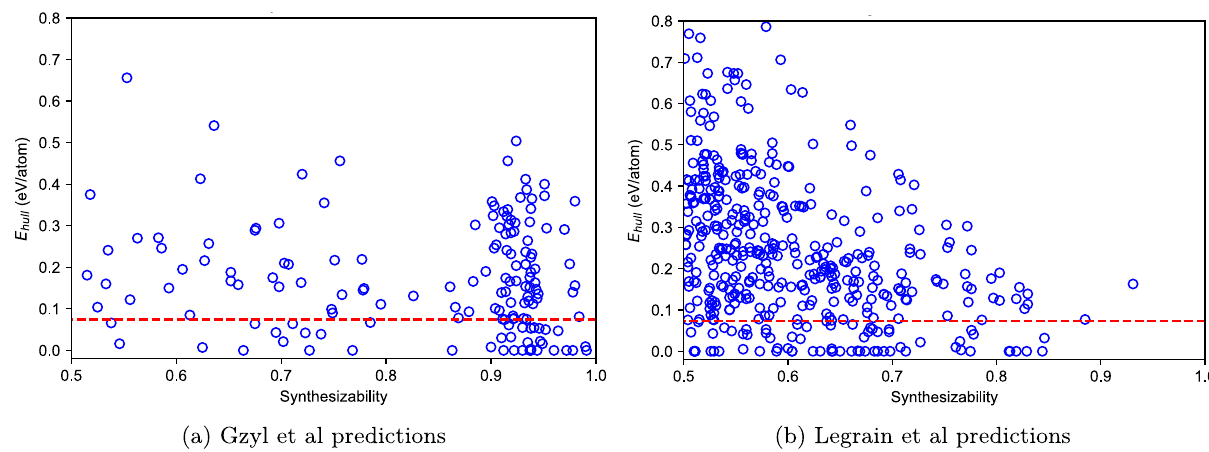
Fig. 2 Synthesizability vs DFT stability for previous half-Heusler models. Comparisons of E hull from the OQMD and synthesizability for synthesizable half-Heuslers as determined by ( a ) Gzyl et al. ’ s 45 and ( b ) Legrain et al. ’ s 46 models. Both models are not informed of DFT stability and predict many unstable half-Heuslers to be synthesizable. The dashed red line depicts the median E hull (73 meV/atom) of all unstable half-Heuslers experimentally reported in the ICSD as calculated in the OQMD.